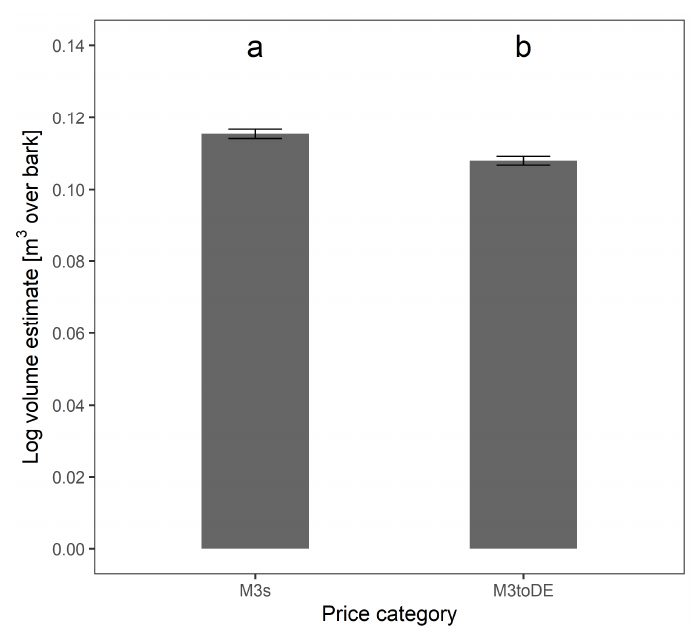
Figure 3. Differences between mean over-bark volumes estimated according to the M3s and M3toDE price categories, regardless of Scots pine log assortment grade. The different letters (a, b) indicate statistically significant differences revealed by the paired Wilcoxon rank-sum test (α = 5%), error bars indicate a 95% confidence interval.